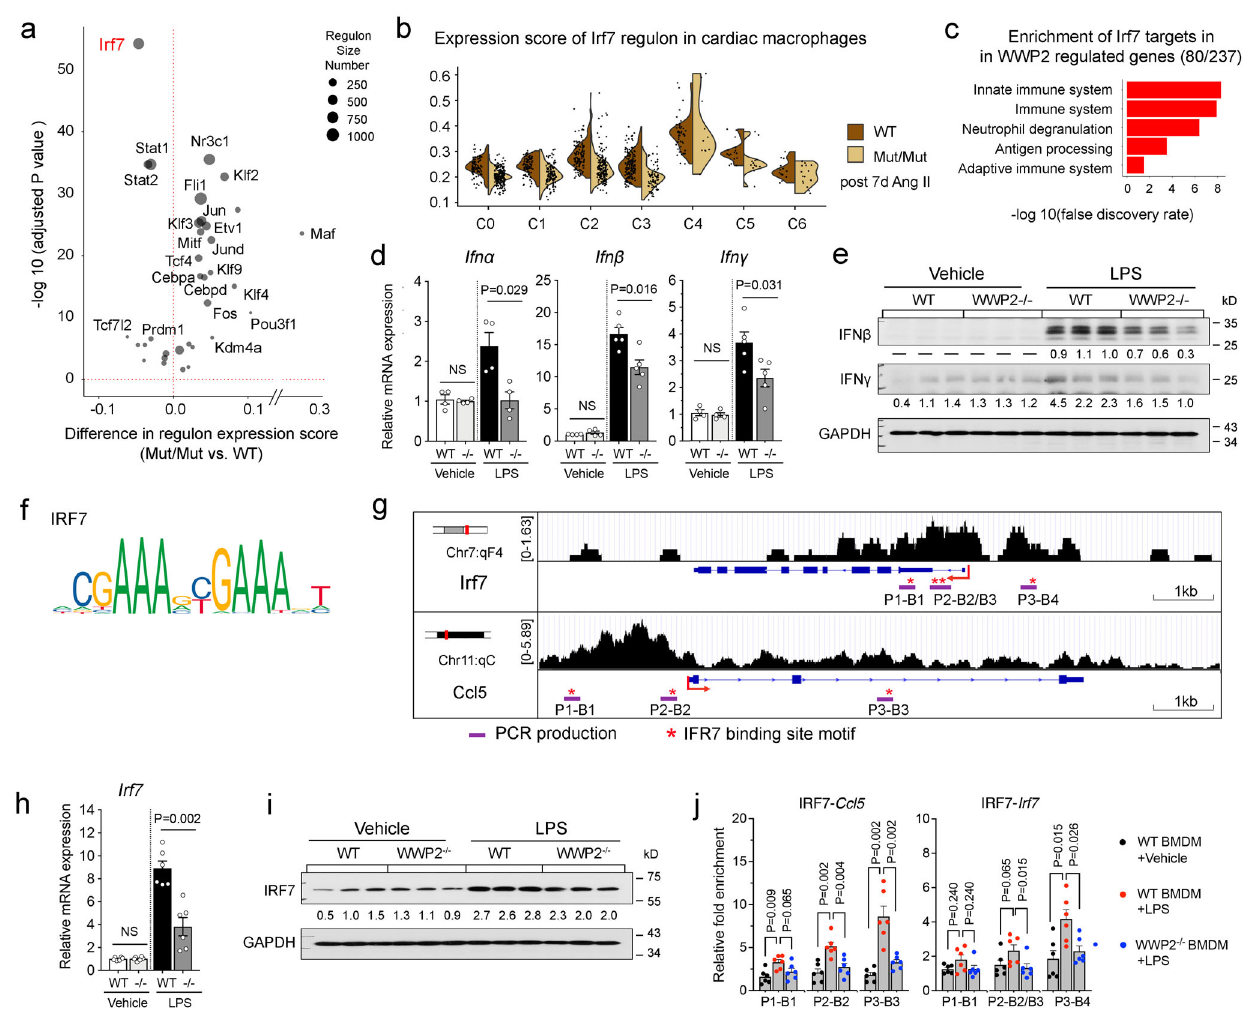
Fig. 5 | WWP2 regulates IRF7 network activity in macrophages in NICM. a Scatterplotoftherelativeactivityoftranscriptionfactor(TF)-regulonsincardiac macrophages from WWP2 Mut/Mut (Mut/Mut) and WWP2 wt/wt (WT) mice treated with Ang-II (7 days). For each regulon, the difference in expression score between Mut/ Mut and WTand itsstatisticalsigni fi cance scoreare shownon the x axis and y axis, respectively. The number of downstream target genes in each regulon is propor- tional to the circle size (more details in Methods). The IRF7 regulon showed the largestandmostsigni fi cantexpressionscoredifferencebetweenMut/Mutand WT cardiac macrophages. b Average expression score of the IRF7 regulon across car- diacmacrophage clusters from WT and Mut/Mut mice treatedwith Ang-II(7days). ( P values by two-sided Wilcoxon test). c Breakdown of IRF7 targets enrichment in the pro fi brotichECM-network( n =237genes) previouslyidenti fi ed inLVof dilated cardiomyopathy patients 39 .80(33.8%)ofthese hECM-networkgenes aretargets of IRF7. d , e qRT-PCR( d )andWB( e )ofrepresentativeIFNsignalinggenes(IFN α ,IFN β